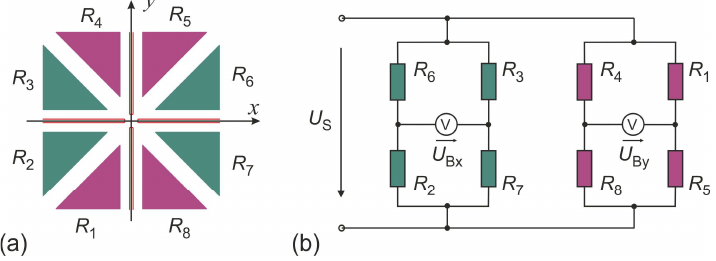
Figure 4. Membrane view ( x–y -plane) of excess temperature of three design alternatives. All devices comprise eight thermistors (two orthogonal arrangements, each comprising four thermistors) and heaters. As a heat source serve either heaters (i.e., calorimetric operating mode as depicted in ( a )) or a self-heating e ff ect of the thermistors ( b , c ).